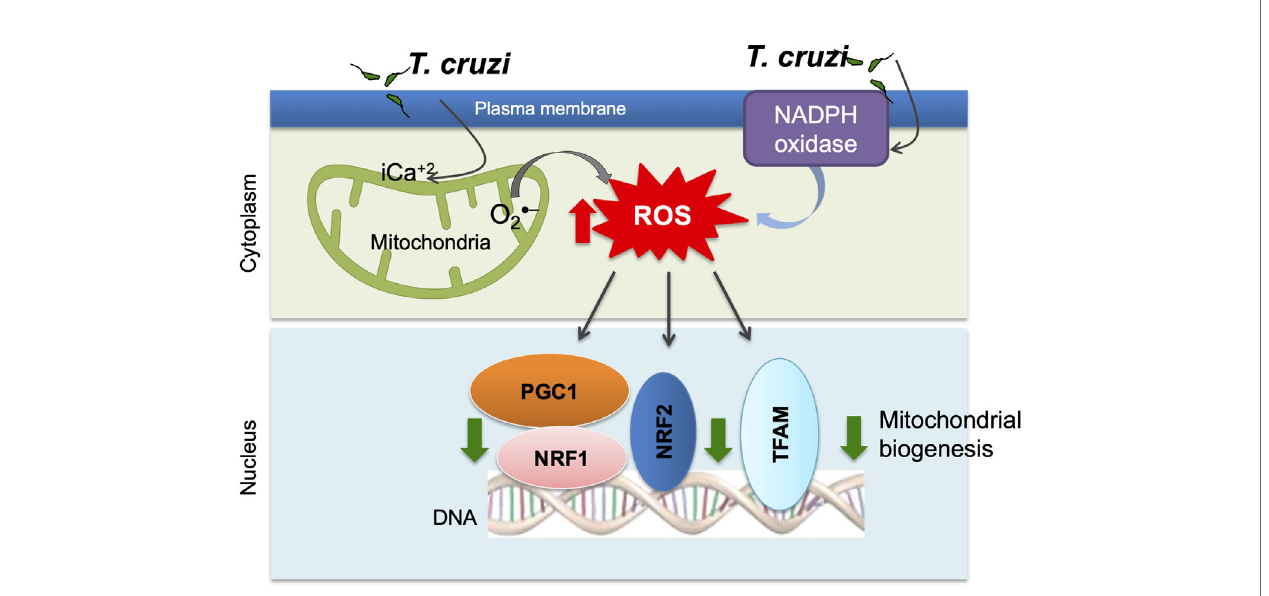
FIGURE 2 | Potential mechanism of mitochondrial dysfunction in Chagas disease. T. cruzi uptake by monocytes/macrophages activates NADPH oxidase-mediated superoxide and ROS production. T. cruzi induces intracellular Ca 2+ fl ux that causes mitochondrial membrane permeability transition, respiratory complex inef fi ciency, and increased leakage of electron from electron transport chain to oxygen, resulting in superoxide production. ROS suppress mitochondrial biogenesis through inhibition of PGC-1 a -mediated transcriptional activation of NRF1/2 and TFAM that maintain redox homeostasis and mtDNA replication and transcription.